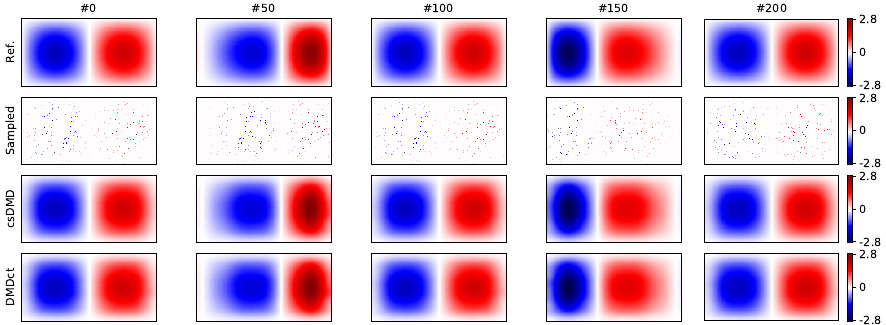
Figure 3. Five sample snapshots of the fully-sampled dataset reconstruction for the double-gyre dataset. The top row shows the reference snapshots titled with the snapshot numbers. The second row shows the random samples taken. The third and the fourth rows show csDMD and DMDct reconstructions,